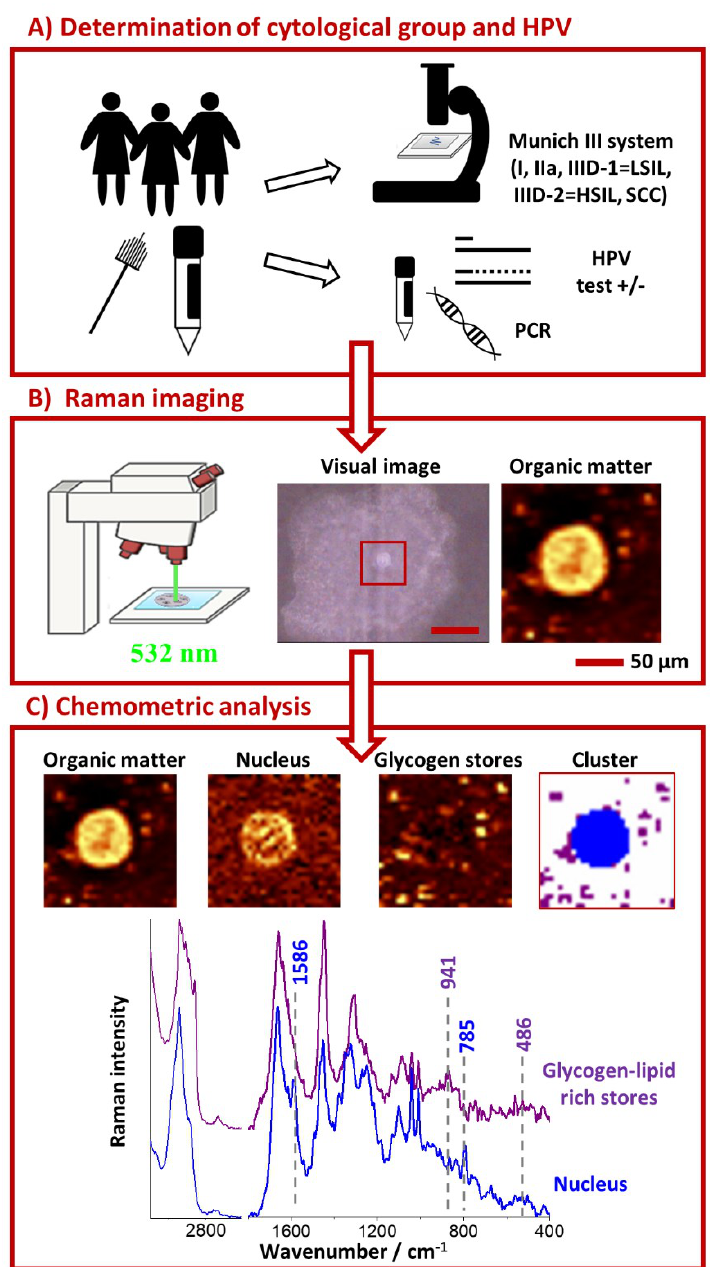
Figure 6. The scheme of the experiment layout . Cell cytological classification and testing for HPV infection ( A ), cell measurement by Raman microscopy ( B ) followed by Cluster Analysis and comparison of spectra between groups ( C ).